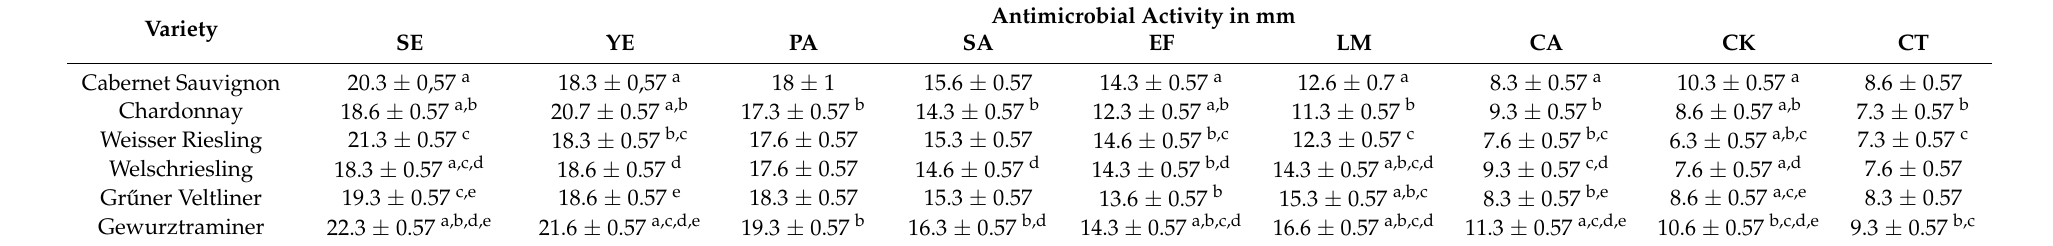
Table 2. Antimicrobial activity of different grape variety in